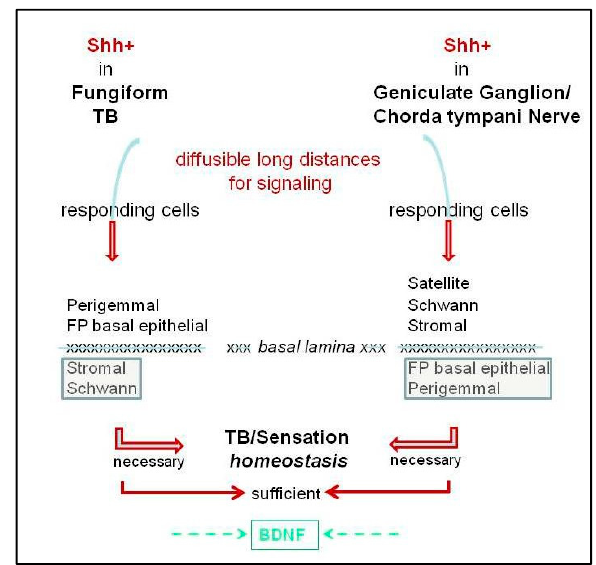
Figure 4. Proposed Hh signaling from Shh ligand in fungiform papilla taste bud and in innervation. Each is necessary for taste bud homeostasis, but only signaling from both is sufficient. The Shh ligand is within taste bud cells (TB) and geniculate ganglion neurons/chorda tympani nerve fibers. The ligand can signal over long distances to responding cells in different compartments of the fungiform papilla and ganglia and tongue. Paracrine signaling from Shh in TB cells has been demonstrated [1,3,13] and signaling from Shh in ganglion/nerve fibers is proposed [3,4,6,13]. If Shh is sequestered within or can traverse the basal lamina, then signaling from both sources will potentially cross to compartments beyond the papilla epithelium (left) or nerve/stromal tissues (right). We propose that signaling in the epithelium and via innervation each is necessary for TB homeostasis and sensation, but only together are they sufficient. BDNF is added at the bottom of the diagram to acknowledge the roles of this neurotrophin in TB homeostasis [57–59].